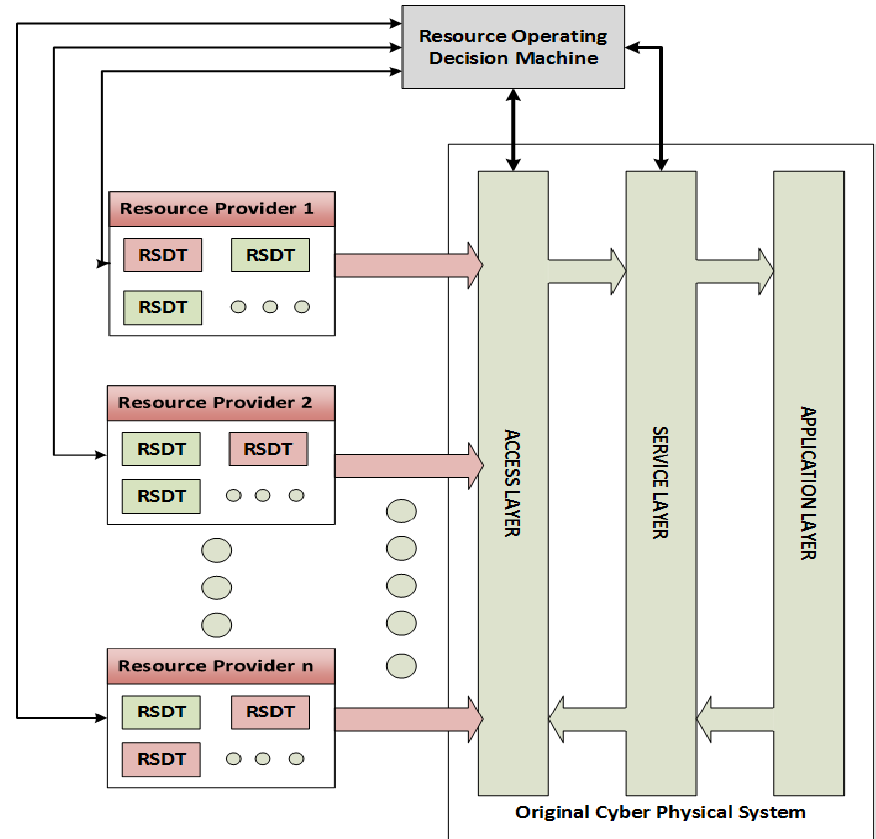
Figure 2. Applying the dynamic resource supply model (DRSM) into a cyber-physical